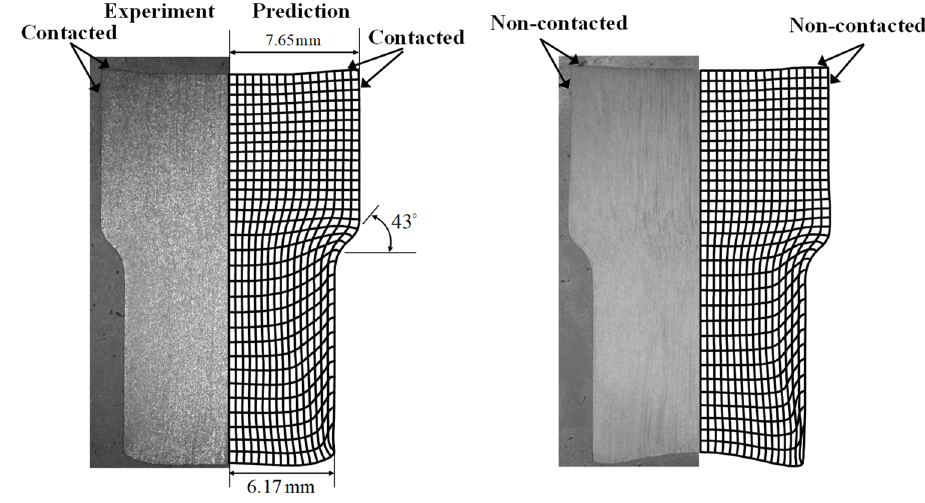
Figure 2. Comparison of the deformed shapes between the experiments and predictions in axisymmetric forward extrusion [4].